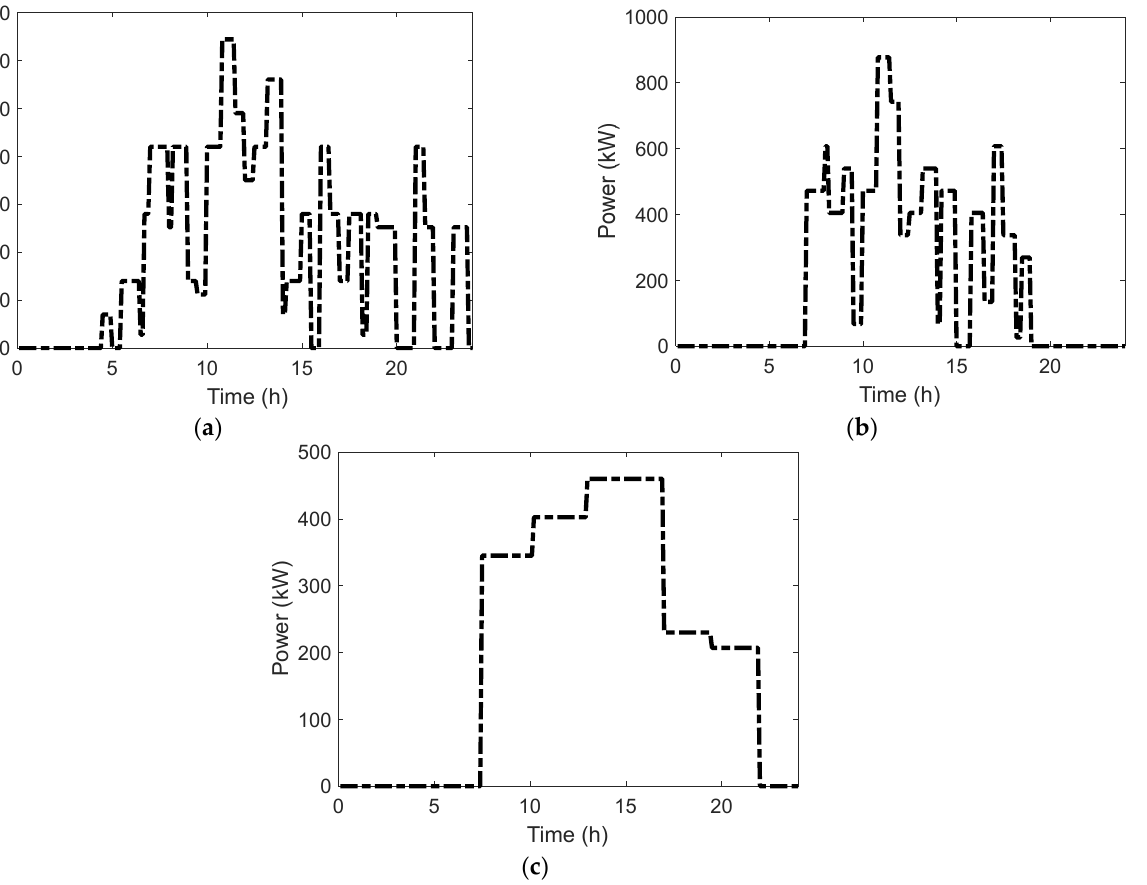
Figure 5. Three different power demand profiles of the proposed system: ( a ) first power load profile, ( b ) second power load profile, and ( c ) third power load profile.